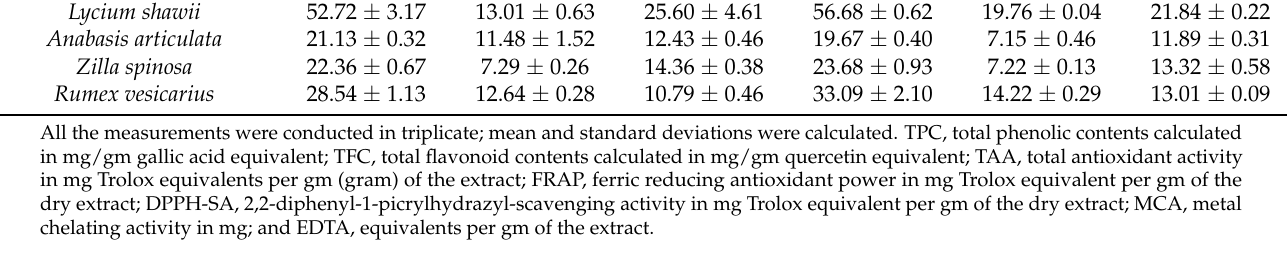
Table 4. Antiproliferative IC 50 values for the plants’ hydroalcoholic extracts.